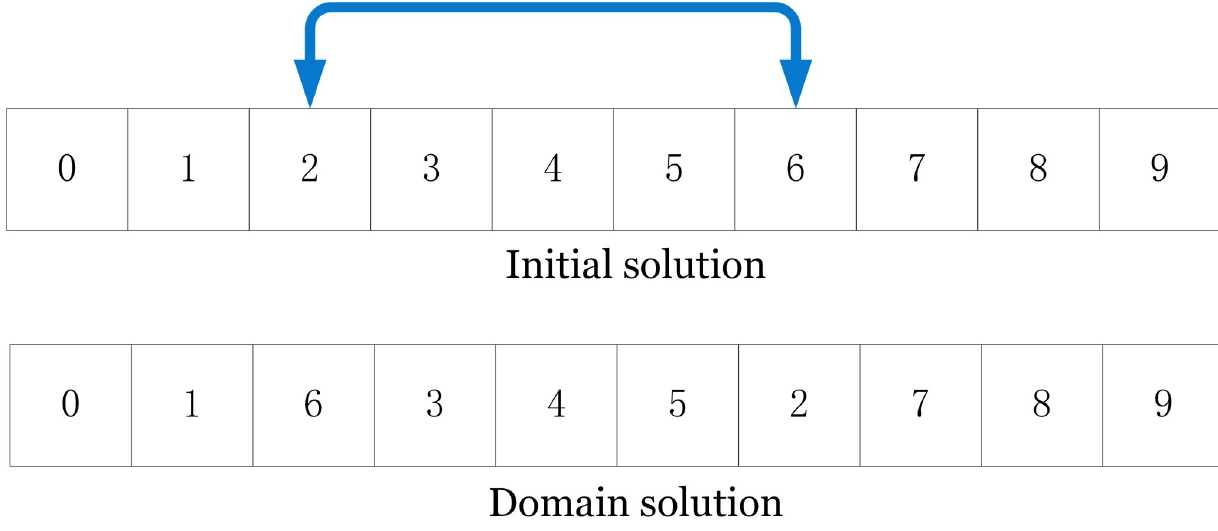
Fig 6. Swap example